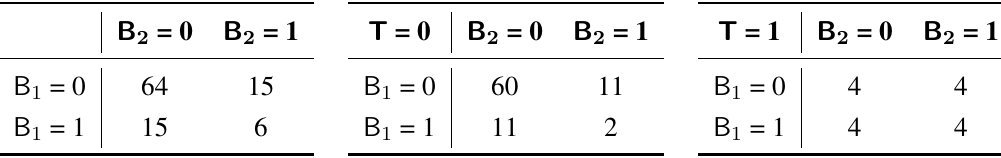
Table 5. Unconditional contingency table of B of B and B given T of dataset DFQR . 1 2